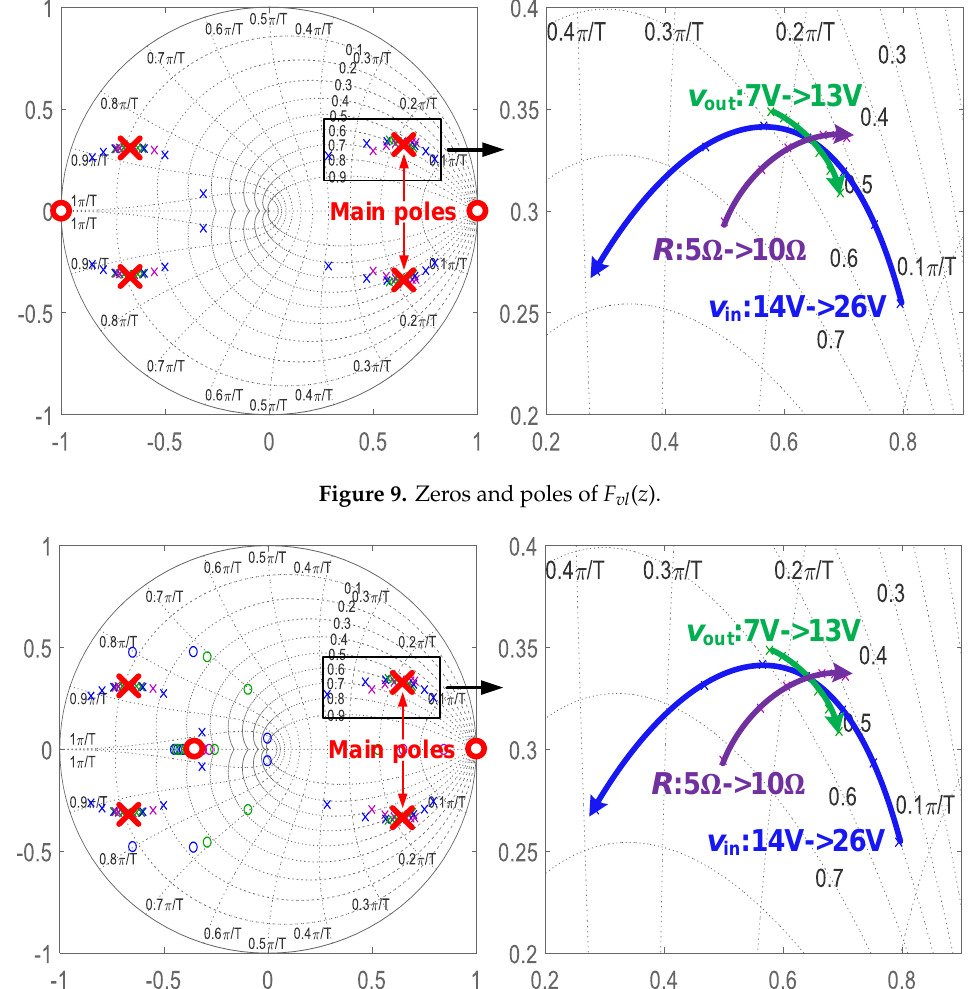
Figure 8. Closed-loop small signal model of the system under deviated operation point.